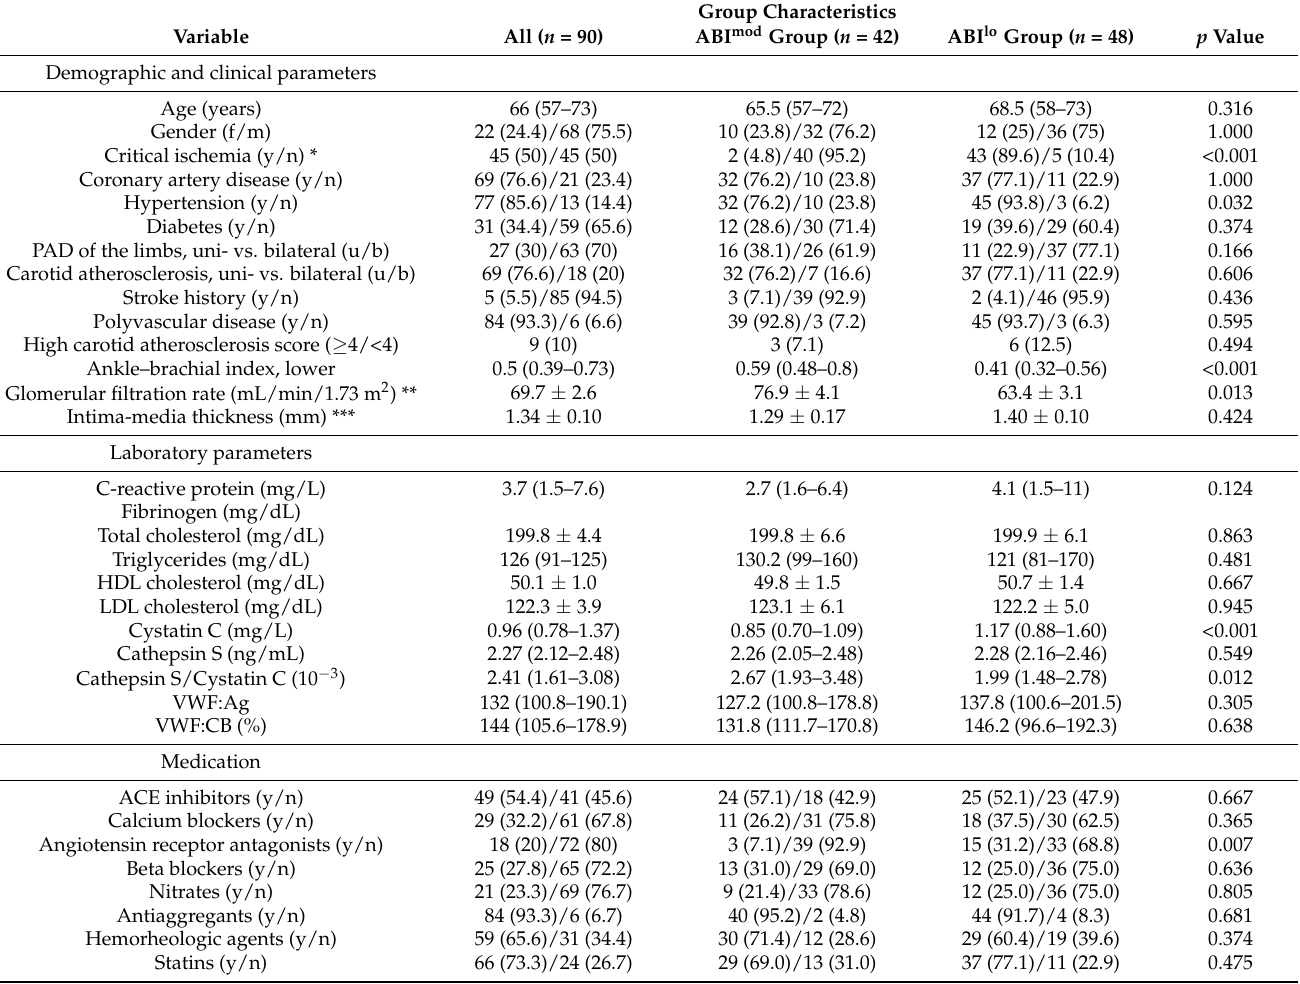
Table 1. Clinical variables of the 90 severe versus non-severe PAD